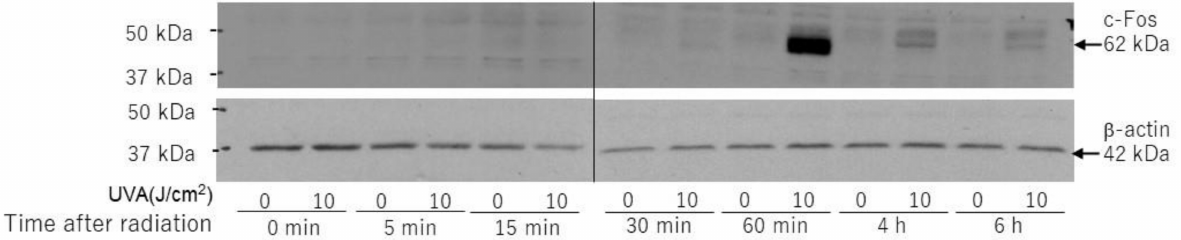
Figure 11. Effects of UVA on protein levels of c-Fos. HDFs were exposed to UVA at the indicated doses in culture and cell lysates prepared at the indicated times post-irradiation were subjected to western blotting as described in the Materials and Methods section. Representative immunoblots from three independent experiments are shown. Consistently, the phosphorylation of JAK2(Tyr221), which occurs upstream of STAT3 (Tyr705) was significantly downregulated at 5 min post-irradiation (Figure